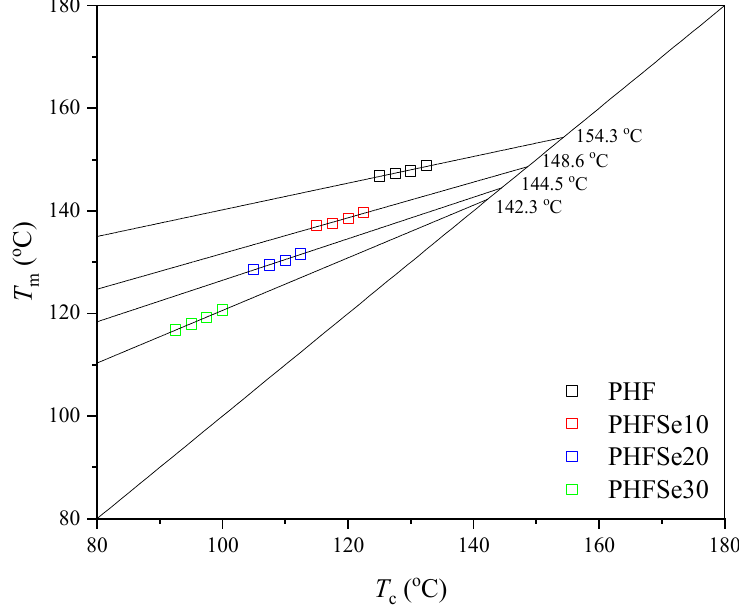
where T m represents the apparent melting temperature at T c , and η assumes values between 0 and 1 and is regarded as a measure of the stability, i.e., the lamellar thickness of the crystals undergoing the melting process. Figure 7 demonstrates the Hoffman − Weeks plots for PHF and PHFSe copolyesters. The T m ◦ values were thus derived to be 154.3, 148.6, 144.5, and 142.3 ◦ C for PHF, PHFSe10, PHFSe20, and PHFSe30, respectively. In brief, with the increase in HSe unit content, the T m ◦ values accordingly decreased.